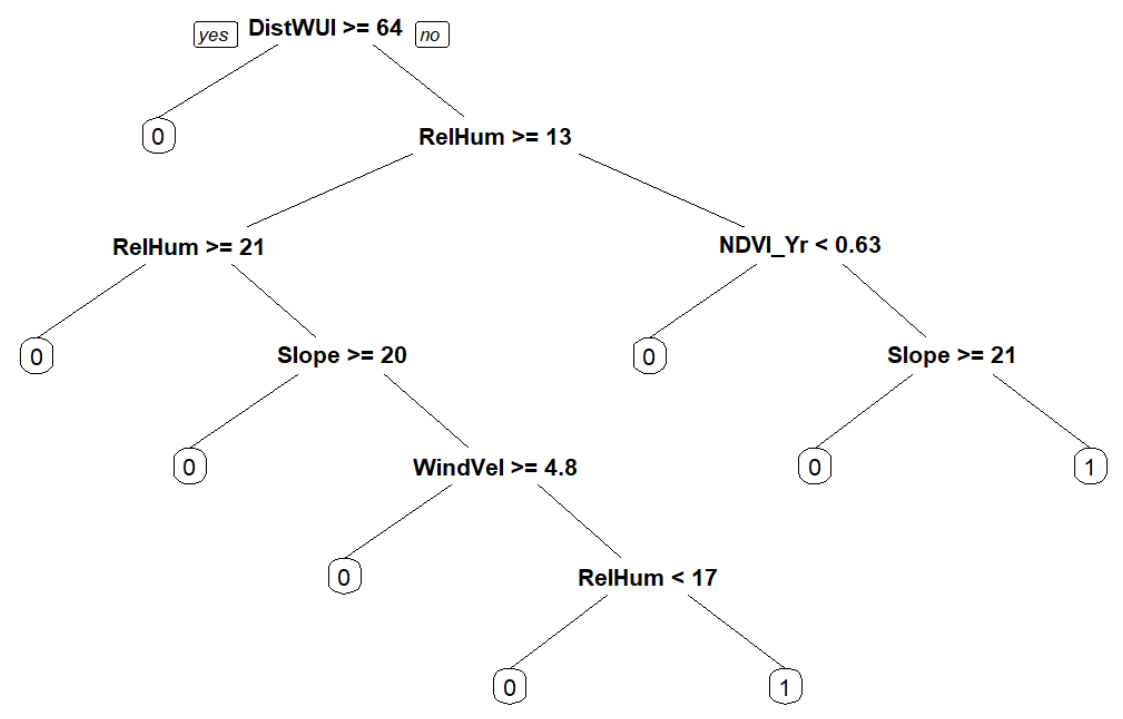
Figure 5. Classification tree explaining the factors differentiating destructive (1) and non-destructive (0) wildfires ≥ 100 ha fr.om 2000–2018 in the Bay Area of California.